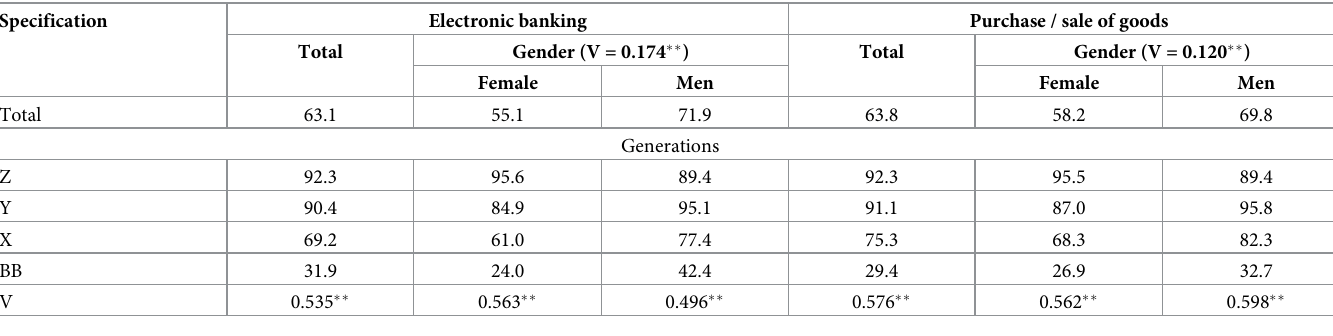
Table 2. Poles’ participation in the digital economy by generation and